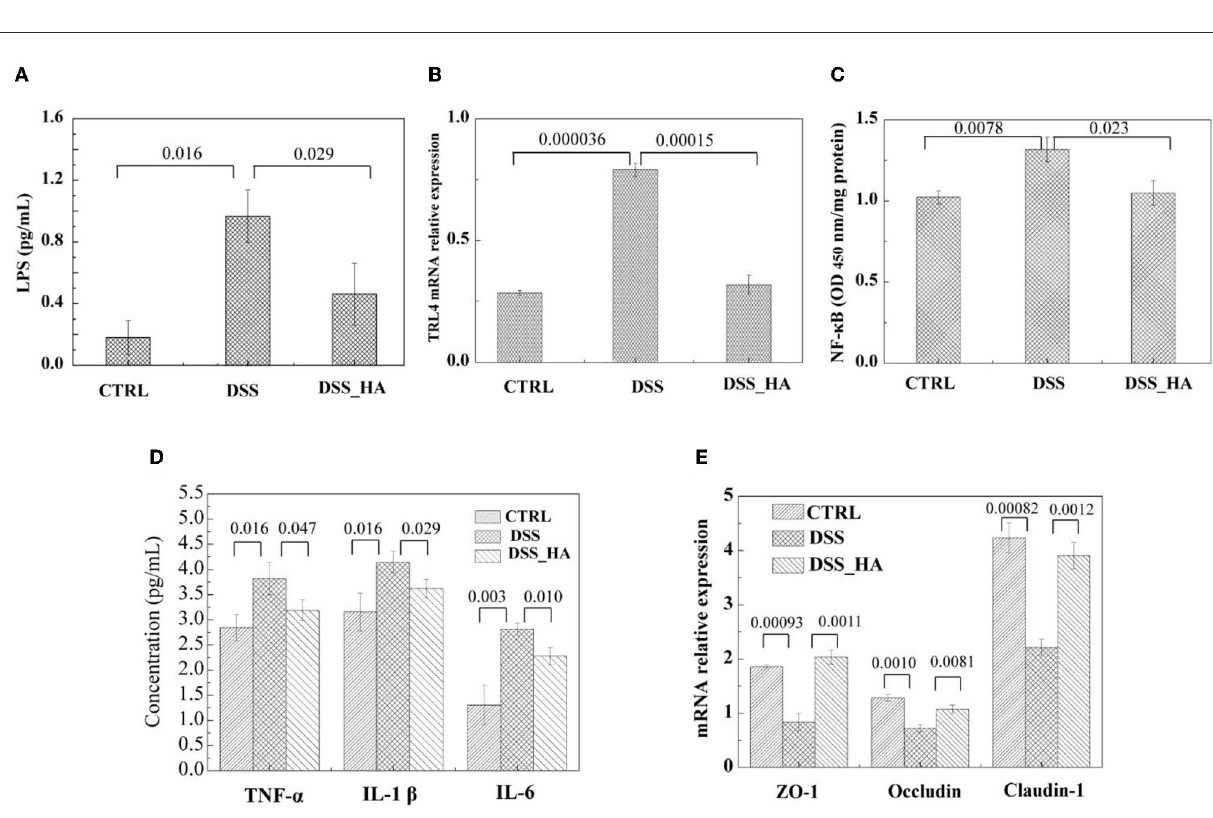
Alteration of the gut microbiota is related to intestinal permeability (Kang et al., 2022; Koutoukidis et al., 2022; Zhang et al., 2022). The intestinal barrier is key to blocking